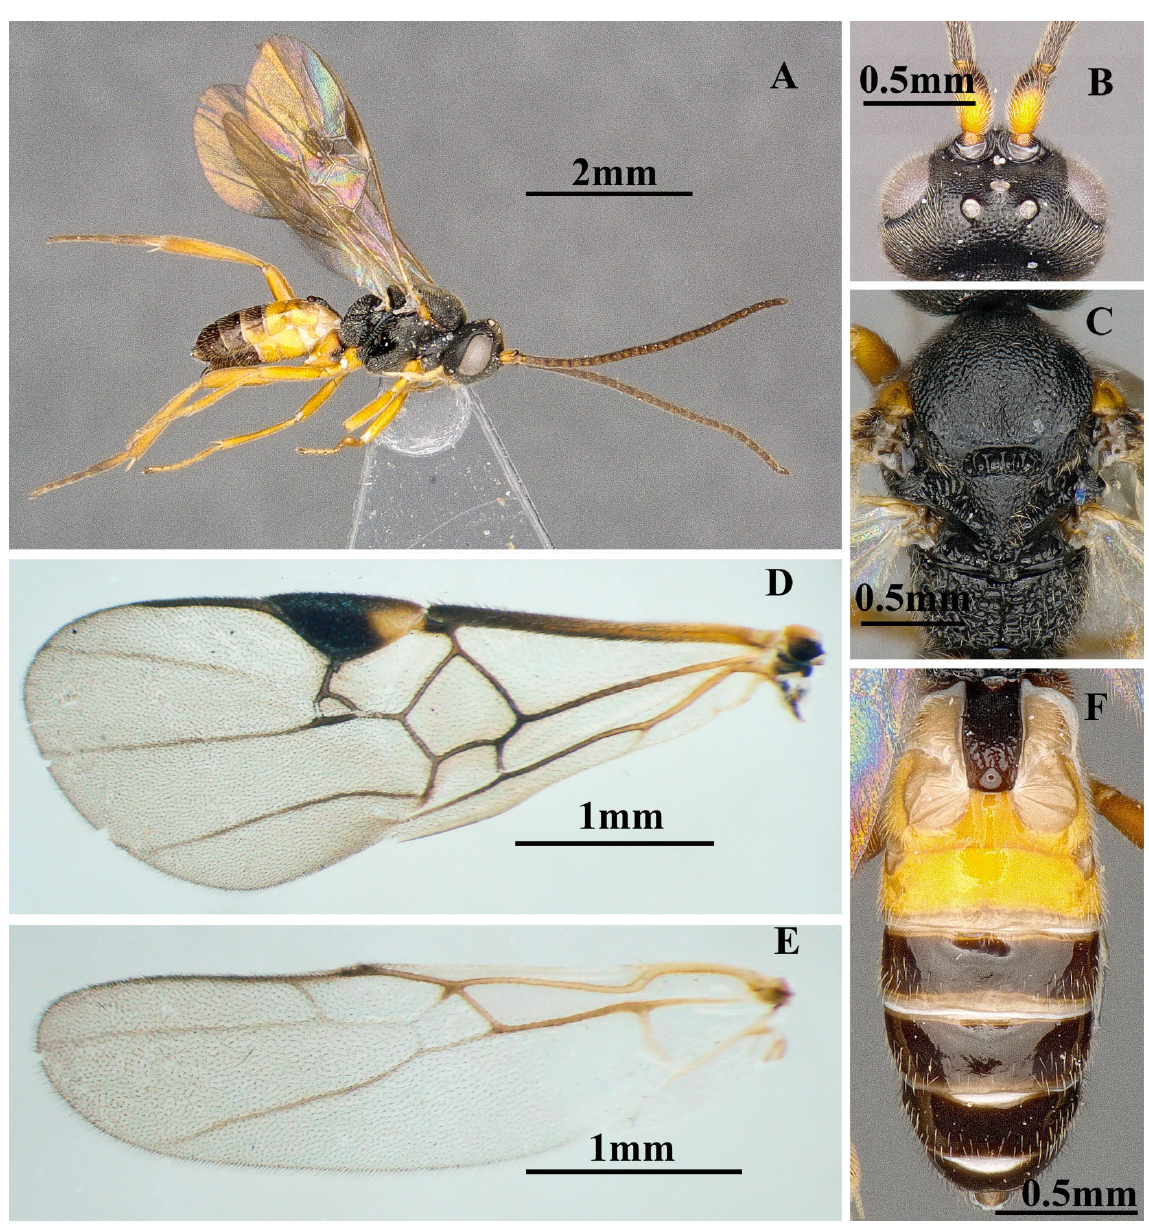
Fig. 13. Microplitis tuberculifer (Wesmael, 1837), ♀, TMUC-HBMMP0335. A . Habitus, lateral view. B . Fore wing. C . Hind wing. D . Head, dorsal view. E . Mesosoma, dorsal view. F . Metasoma, dorsal